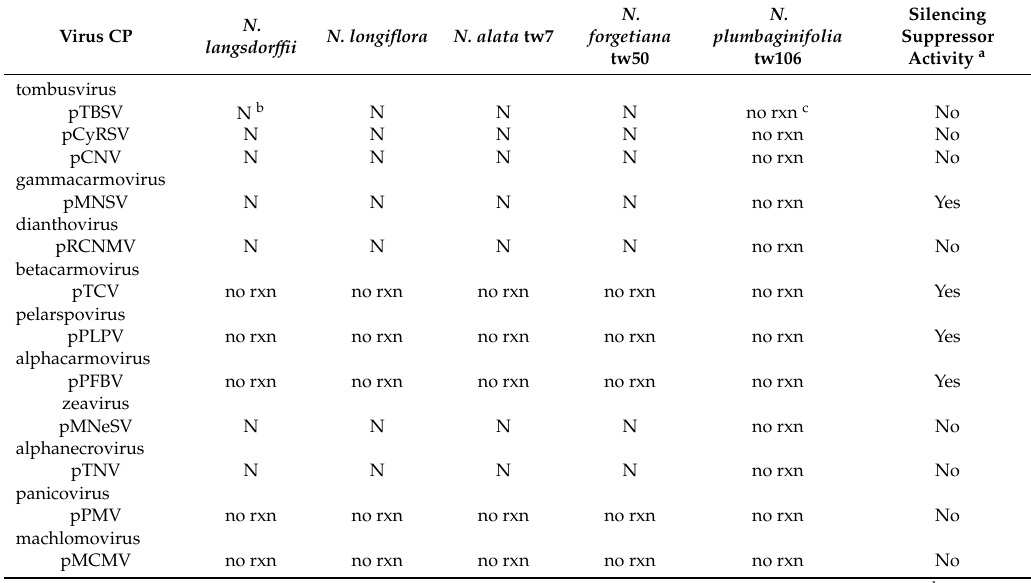
Figure 5. Evaluation of selected CPs of the Tombusviridae for elicitation of necrosis in N. langsdorffii . pTNV-CP and empty vector pKYLX7 were agroinfiltrated into every leaf as positive and negative controls, respectively. Red circles illustrate zones of infiltration for constructs that did not elicit necrosis. Photos were taken at 7 dai. Table 2. Reaction of Nicotiana species in section Alatae to agroinfiltration of CPs of the Tombusviridae and assessment of silencing suppressor function of CPs in N. benthamiana.